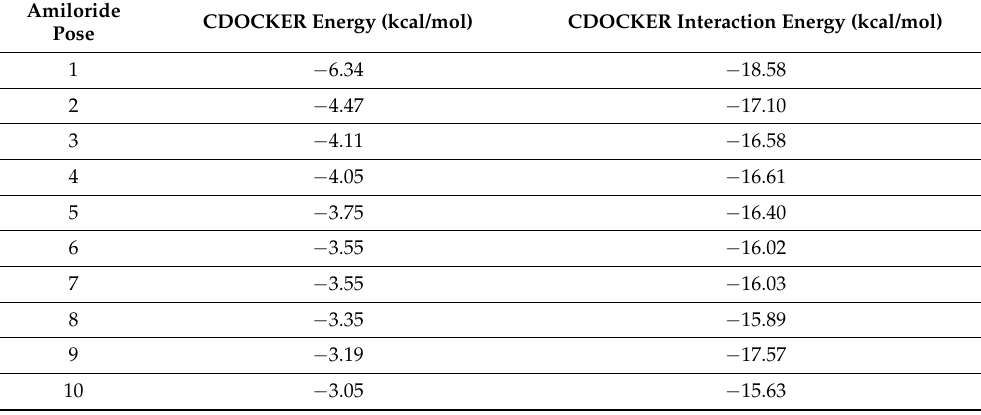
Table 1. CDOCKER Energy and CDOCKER Interaction Energy for amiloride molecules docked in the extracellular vestibule of